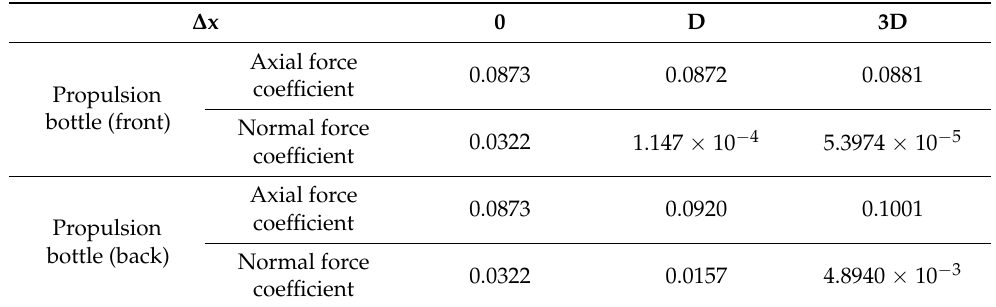
Table 5. Axial and normal force coefficient when propelling bottles are placed at different